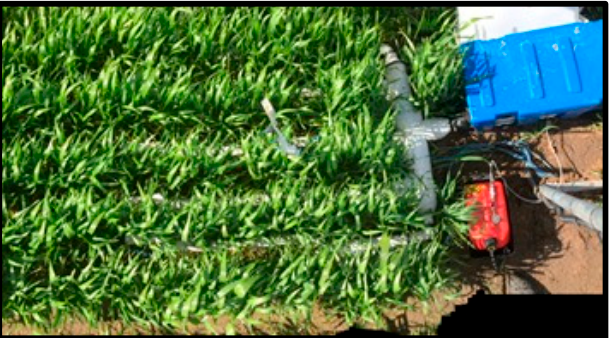
Figure 2. Diesel plot heater set up in a plot at the Dale frost nursery.